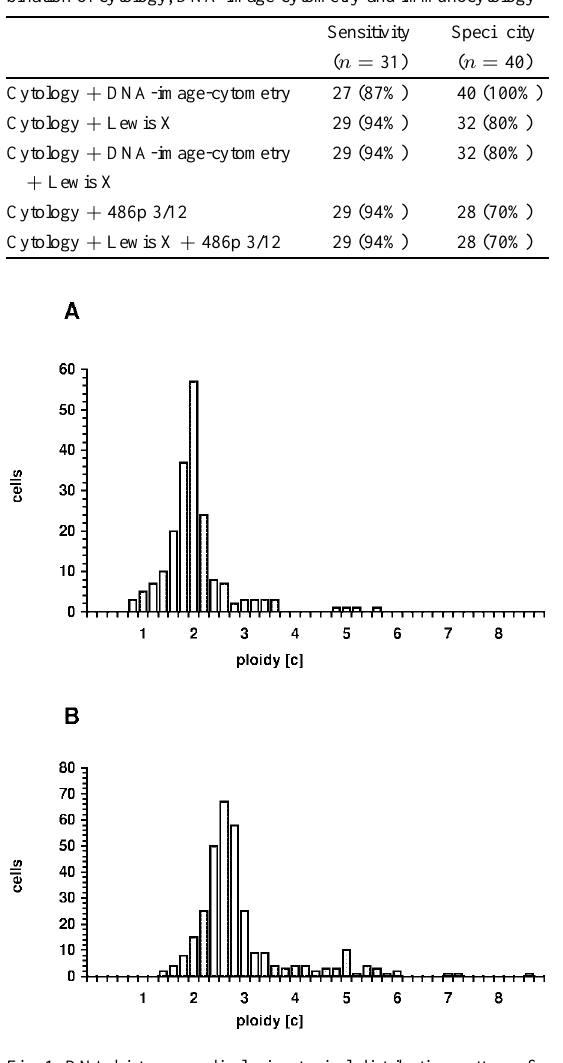
Fig. 1. DNA histograms displaying typical distribution patterns for grade 1 (A) and grade 3 (B) aneuploid urothelial carcinomas. Ane- uploidy was detected by comparison of the reference and test cells. Stemline ploidy of reference cells is